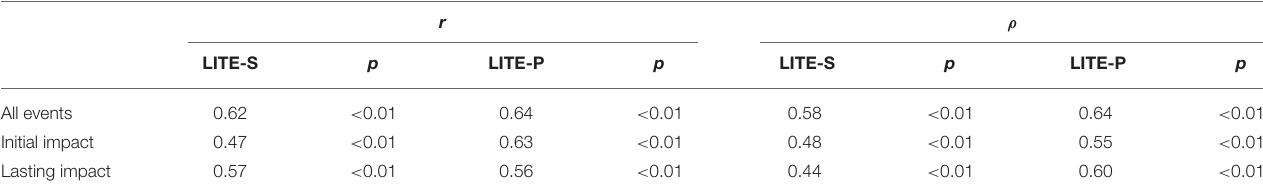
TABLE 4 | Correlations between the first and second LITE assessments ( N =